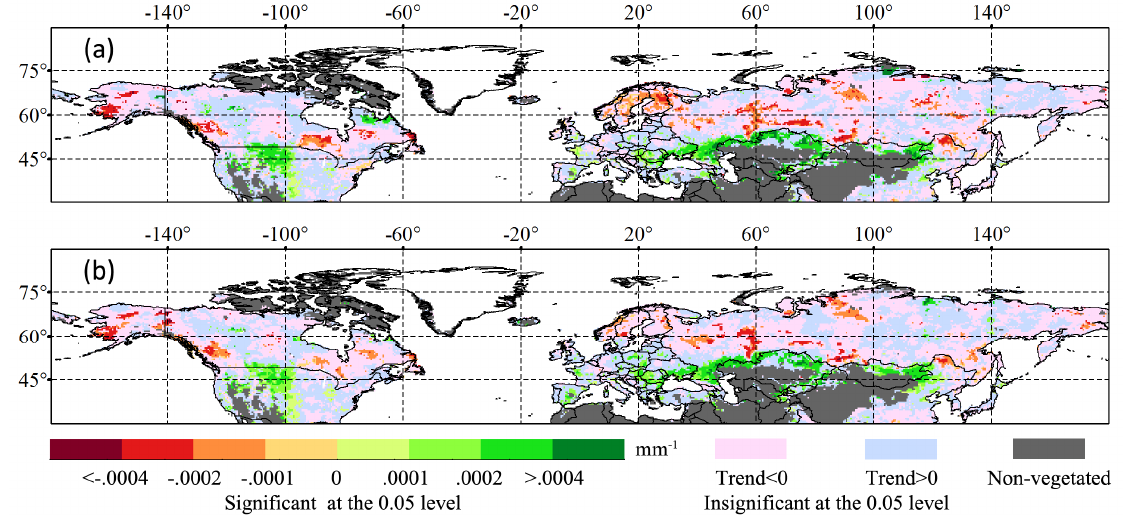
Figure 11. Response of growing-season NDVI to precipitation change detected from ( a ) NDVIg and ( b ) NDVI3g during 1982–2008.